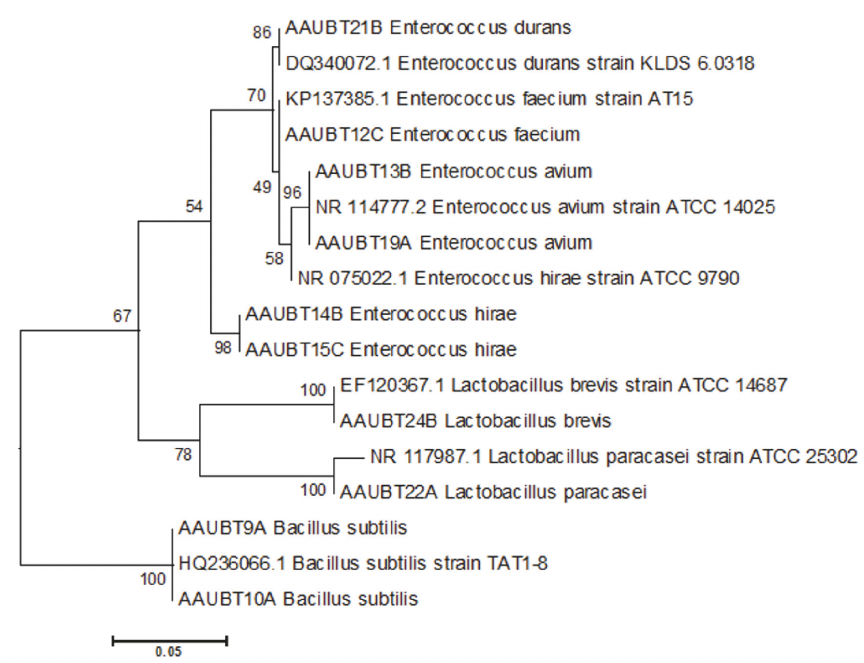
Figure 3: Phylogenetic tree of nucleotide sequence of 10 bacteria isolates from teff dough, i.e., AAUBT15C, AAUBT9A, AAUBT10A, AAUBT22A, AAUBT21B, AUBT24B, AAUBT13B, AAUBT1A9, AAUBT14B, and AAUBT12C. And 7 from GenBank were HQ236066.1, DQ340072.1, NR075022.1, NR117987.1, EF120367.1, NR 114777.2, and